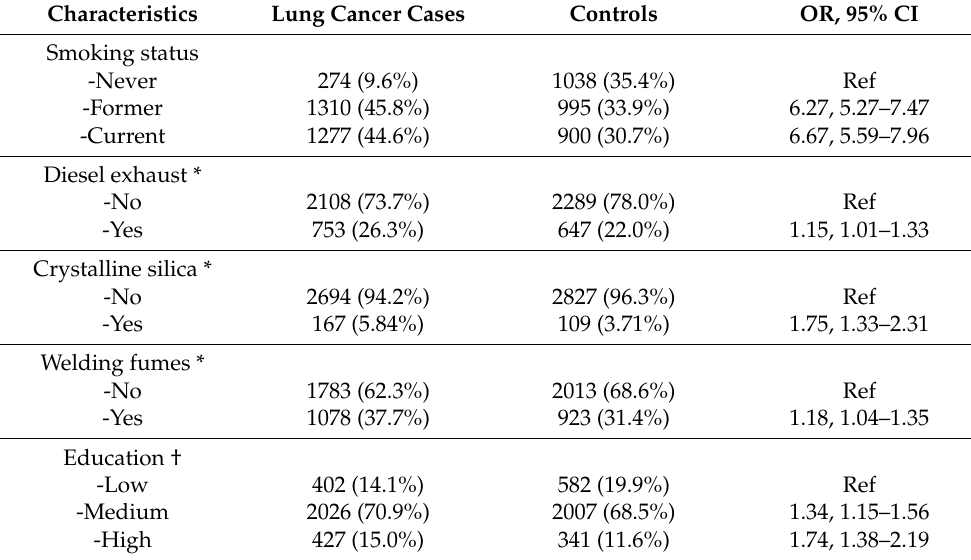
Table 3. Selected characteristics of the study population.